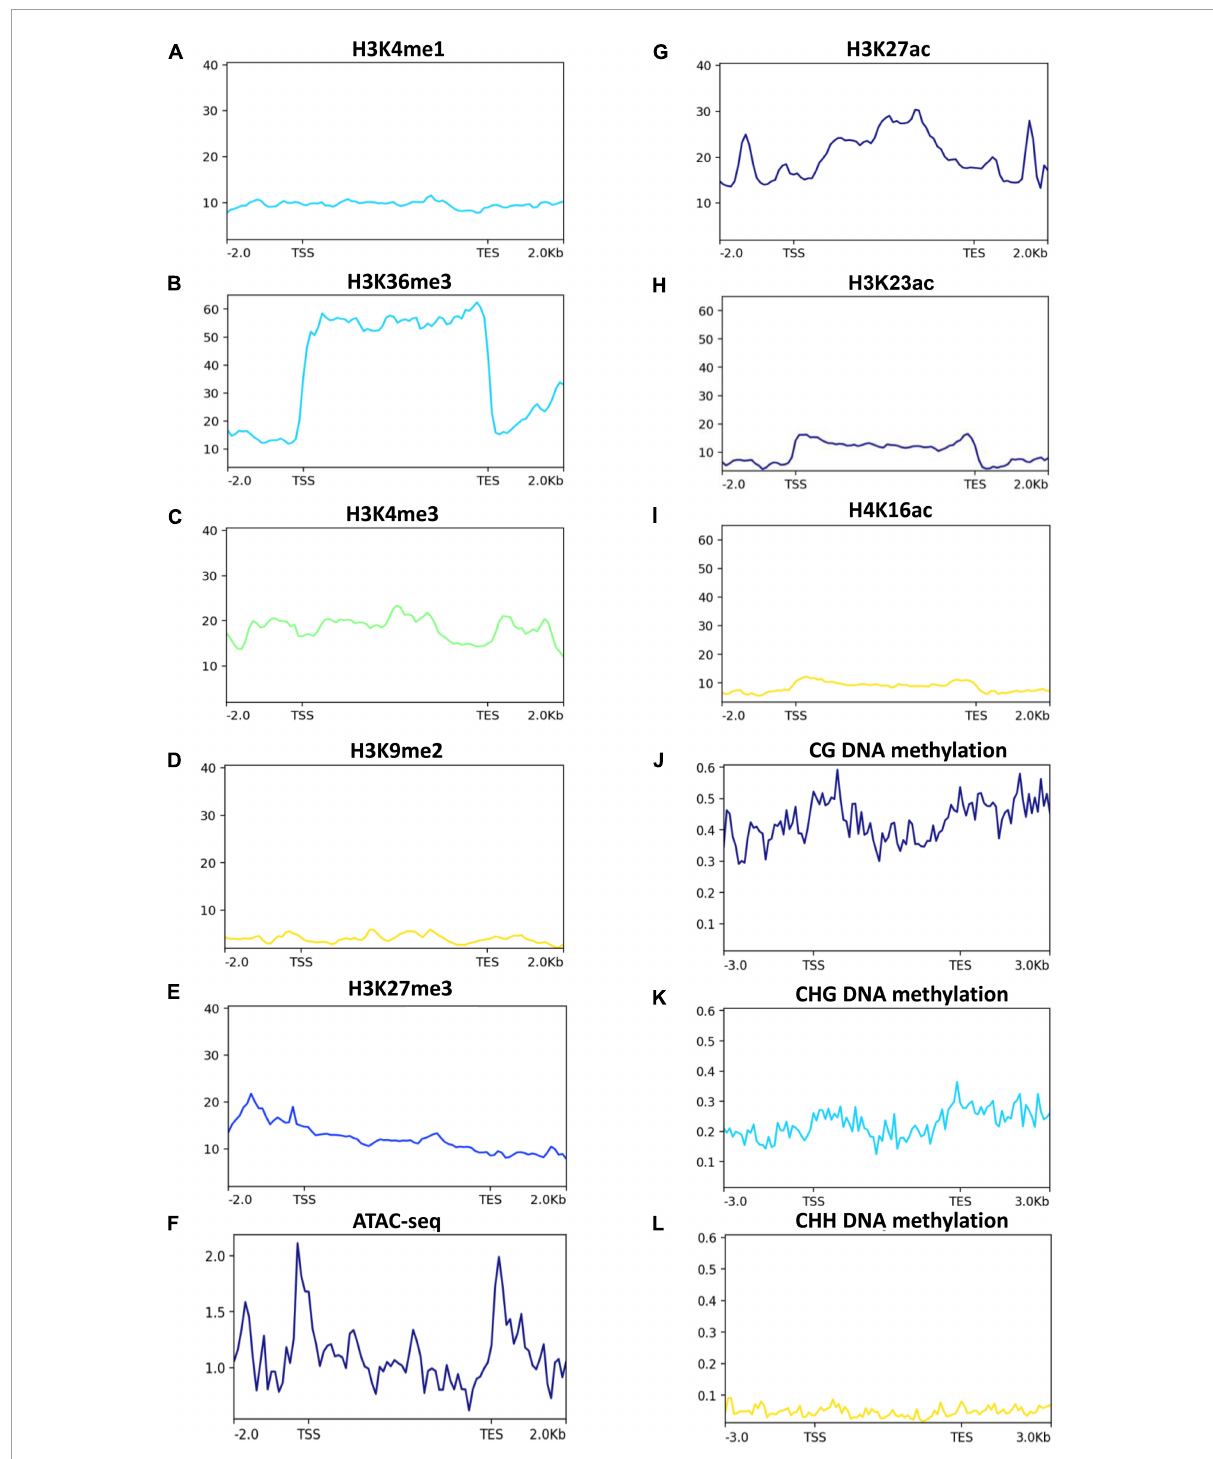
FIGURE6 Histone methylation and chromatin accessibility status in 2-AP biosynthesis pathway-related genes in rice. Published data were used to plot histone methylation and ATAC-seq status. H3K4me1, H3K36me, H3K4me3 (A–C) , are generally associated with transcriptional activation, while H3K9me2 and H3K27me3 and (D,E) are generally associated with transcriptional repression. Chromatin accessibility is determined by Assay for Transposase-Accessible Chromatin using sequencing (I- ATAC-seq) (F) . (G–I) H3K27ac, H3K23ac and H4K16ac are generally associated with transcriptional activation. While DNA methylation (J–L) are generally associated with transcriptional